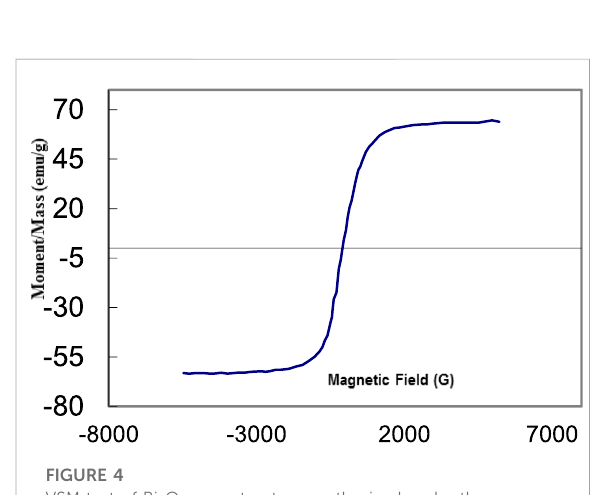
FIGURE 4 VSM test of Bi 2 O 3 nanostructure synthesized under the optimal condition of microwave